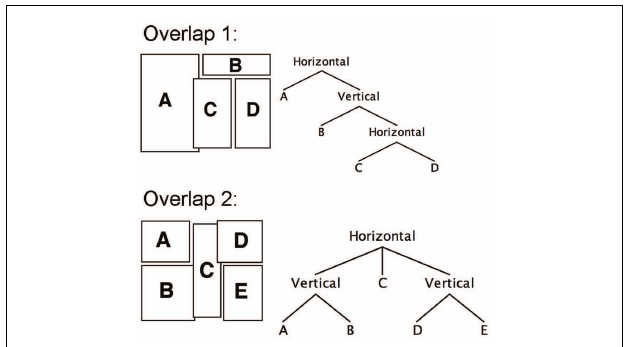
FIGURE 10 |Tree structures for overlapping examples.